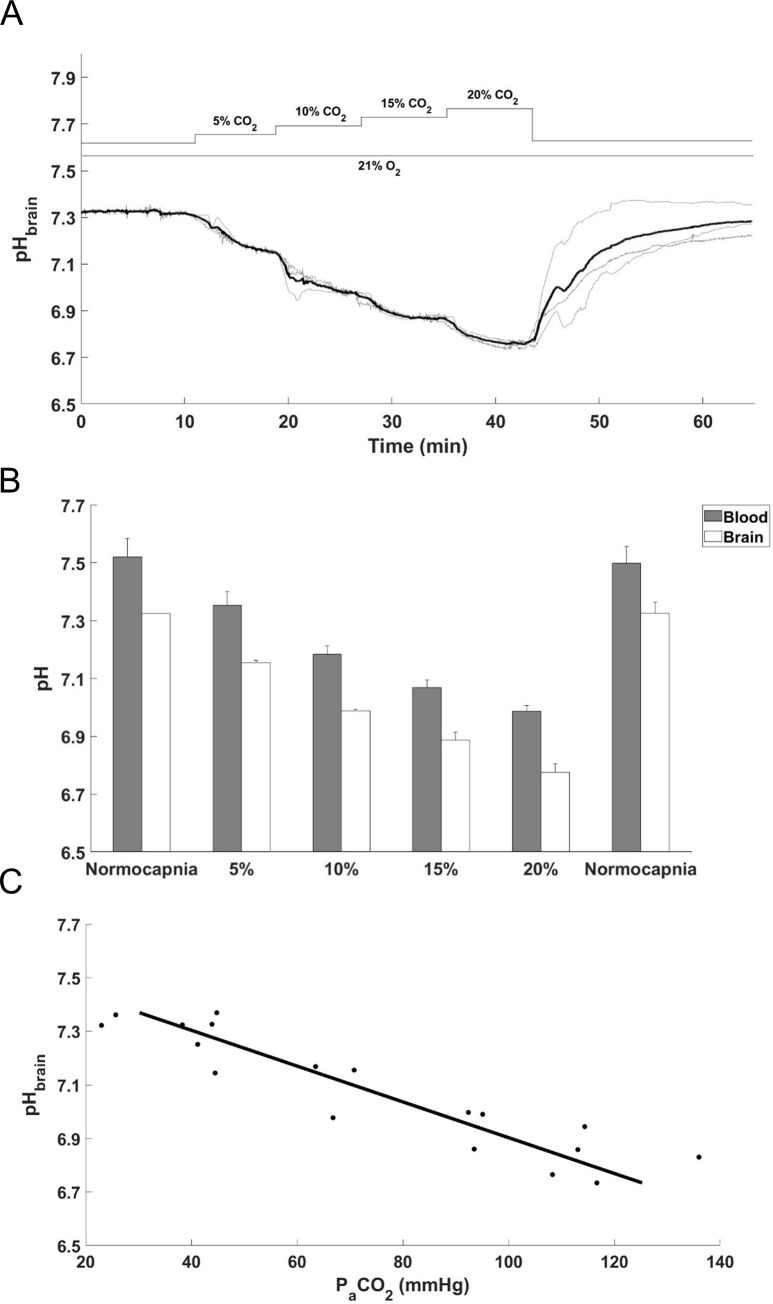
Cerebral acidosis induced by graded normoxic hypercapnia.(A) pHbrain changes during graded normoxic hypercapnia induced by ventilation with 5–20% CO2 followed by restoration of normocapnia (grey lines–individual tracings, bold black line–mean). (B) Simultaneous reductions in pHa and pHbrain during graded normoxic hypercapnia were in accordance with the elevations in PaCO2, the values were (mmHg) 5%: 59.6±7.8, 10%: 84.7±9.0, 15%: 107.0±6.7, 20%: 120.3±8.2, (mean±SEM; n = 3). Corresponding PaO2 values were (mmHg) 5%: 75.5±12.8, 10%: 78.2±11.3, 15%: 85.5±8.2, 20%: 84.5±9.8, (mean±SEM; n = 3). (C) Linear regression shows close correlation between PaCO2 and pHbrain (R2 = 0.8546) values obtained during graded hypercapnia (5–20% CO2).